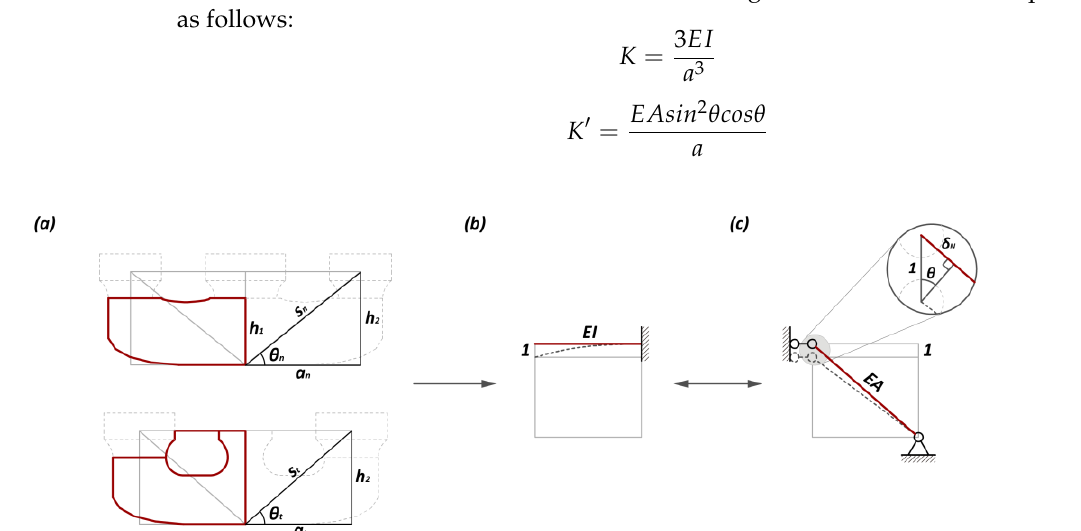
Figure 12. Calculation flow of the sectional reduction factors for the Dan- and Hua-gongs: ( a ) dimension of the Dan- and Hua-gong; ( b ) vertical stiffness of a cantilever beam; ( c ) vertical stiffness of the equivalent truss element.